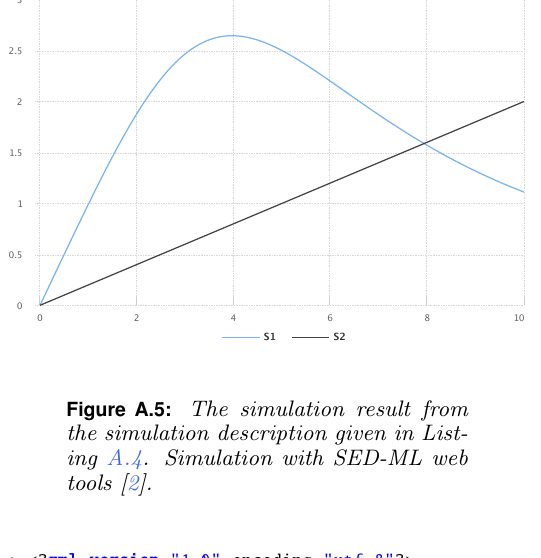
Figure A.5: The simulation result from the simulation description given in List- ing A.4. Simulation with SED-ML web tools [2].